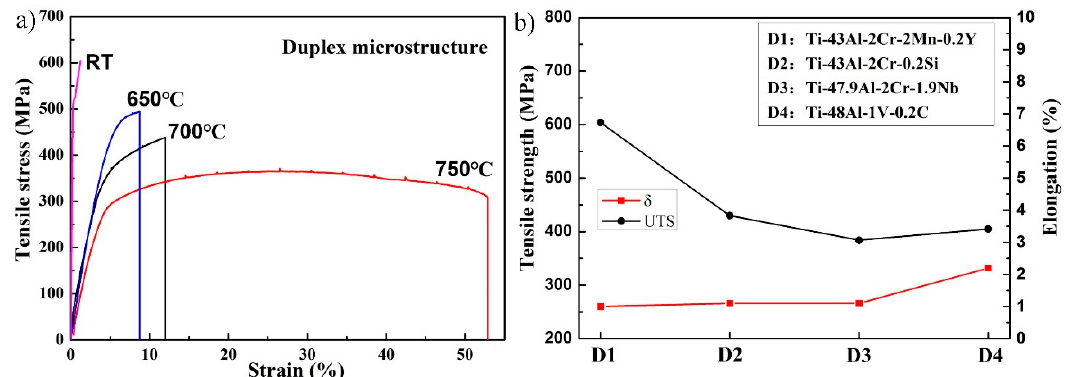
Figure 6. Tensile properties of as-forged TiAl alloys with DP microstructure: ( a ) tensile curves of the Ti–43Al–2Cr–2Mn–0.2Y alloy with DP microstructure, and ( b ) the comparison of tensile properties of various TiAl alloys with DP microstructure [28,29].